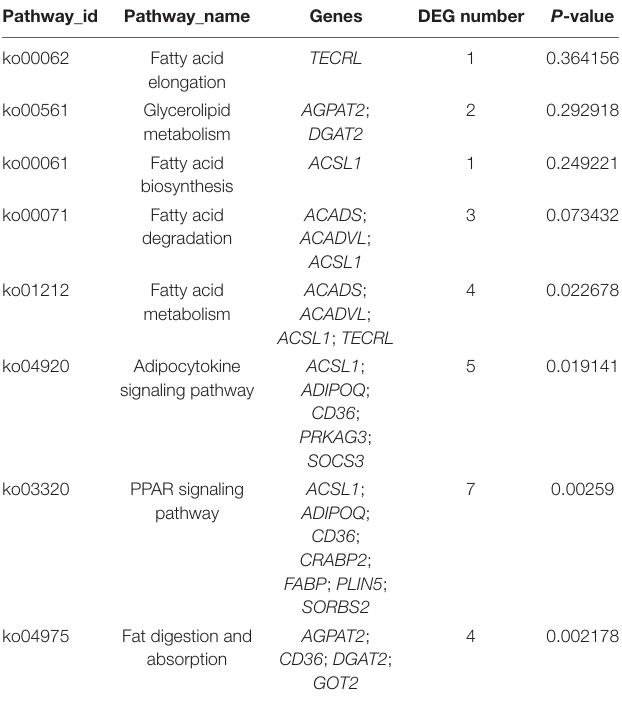
TABLE 1 | Eight significantly enriched pathways related to fatty acid